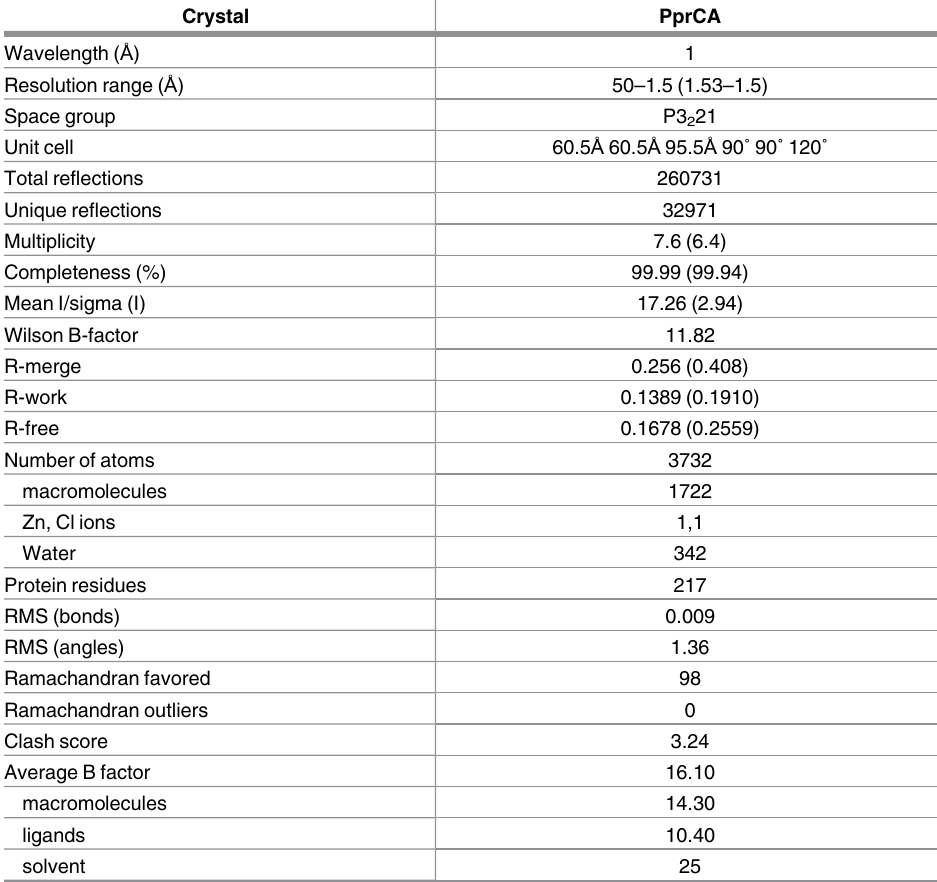
Table 1. Data collection and refinement